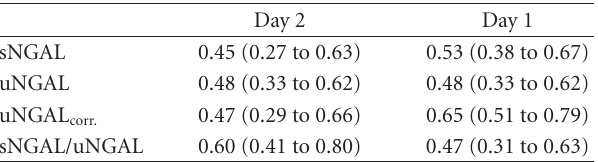
Table 3: AUC (CI) for sNGAL, uNGAL, and uNGAL corr. in pre- dicting AKI.